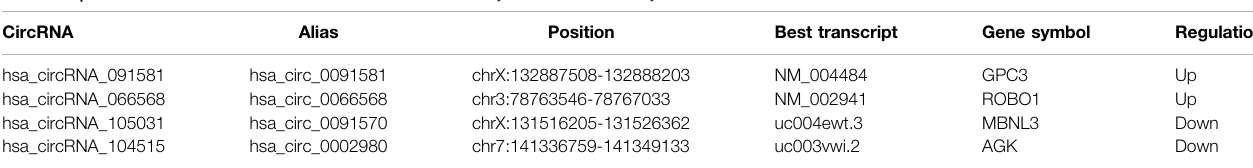
TABLE 3 | The basic information of the four circRNAs identi fi ed by bioinformatics analyses.